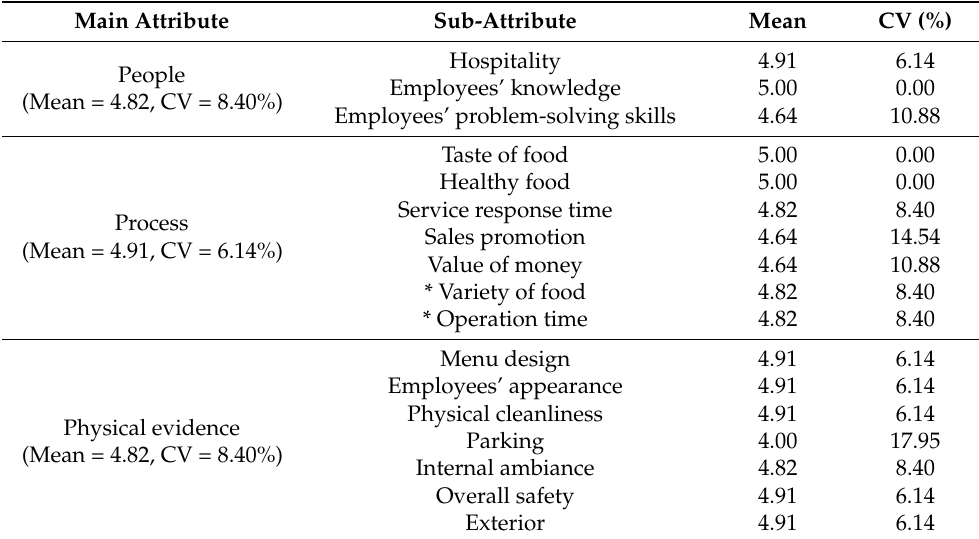
Table 5. The mean and CV values of the finalized